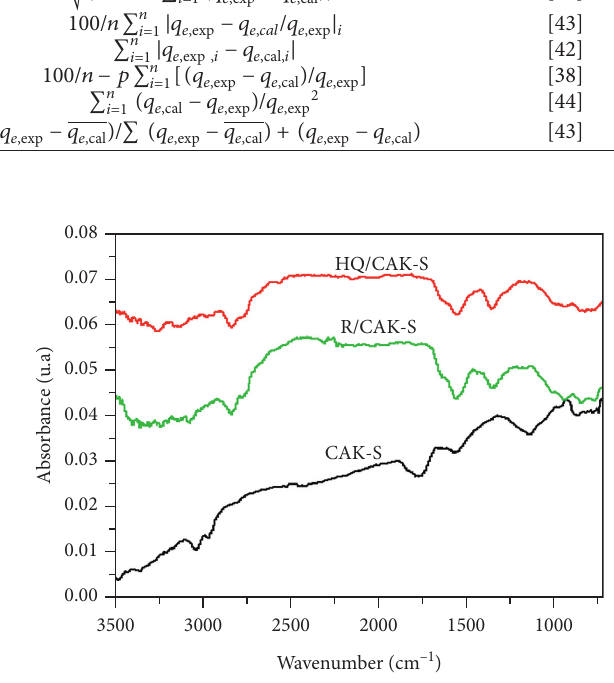
Figure 2: FTIR spectrum of CAK-S before and after adsorption of HQ and